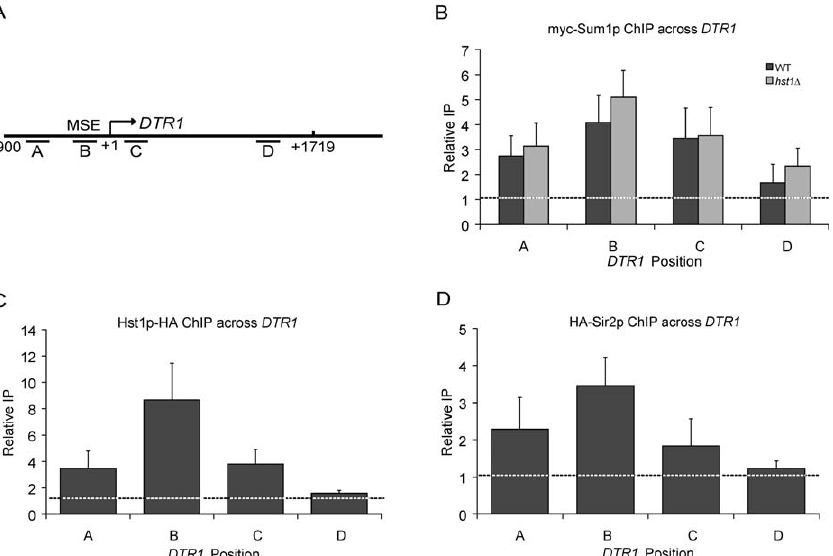
Figure 5. Sir2p Does Not Alter the Spreading Properties of the Sum1 Complex (A) The positions of PCR amplicons in the DTR1 locus are shown. (B) The distribution of myc-Sum1p at the DTR1 promoter in wild-type (LRY523) and hst1 D (LRY521) strain backgrounds was assessed by ChIP followed by quantitative PCR. The y-axis represents the enrichment of DTR1 relative to ATS1 . A value of one (dashed line) corresponds to no enrichment. (C) The distributions of Hst1p-HA in a wild-type (LRY558) background and (D) HA-Sir2p in an hst1 D (LRY198 with pRO298) background were assessed as in part B.